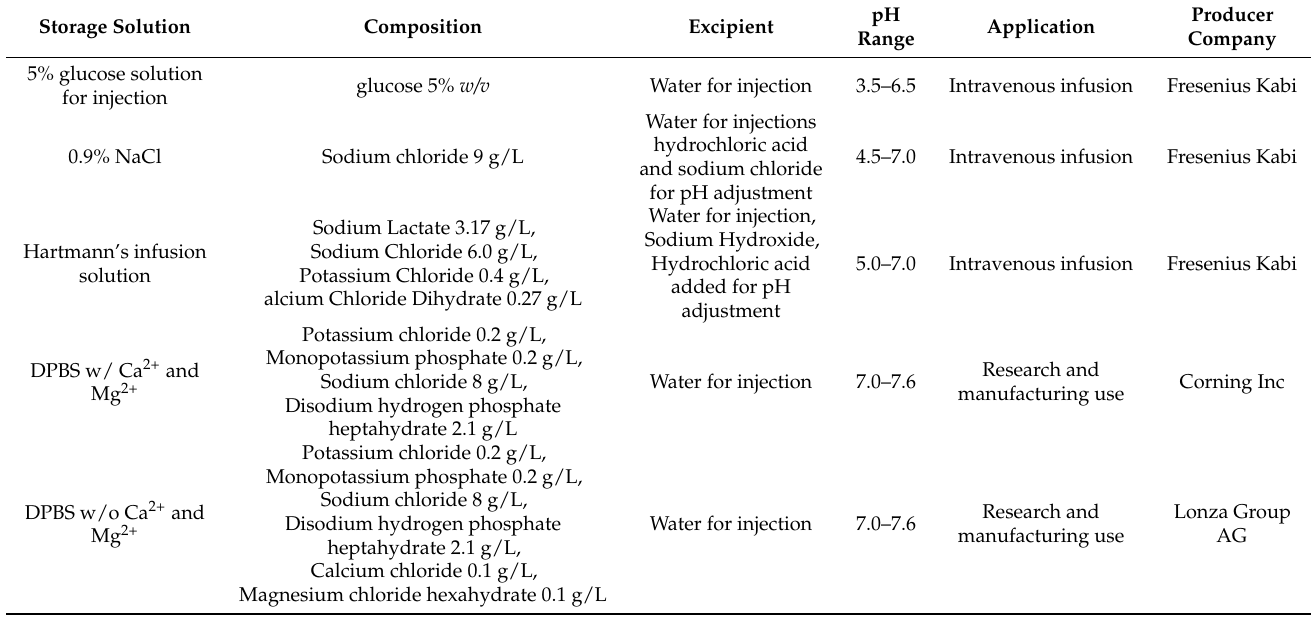
Table 2. Information on the solutions used in the stability